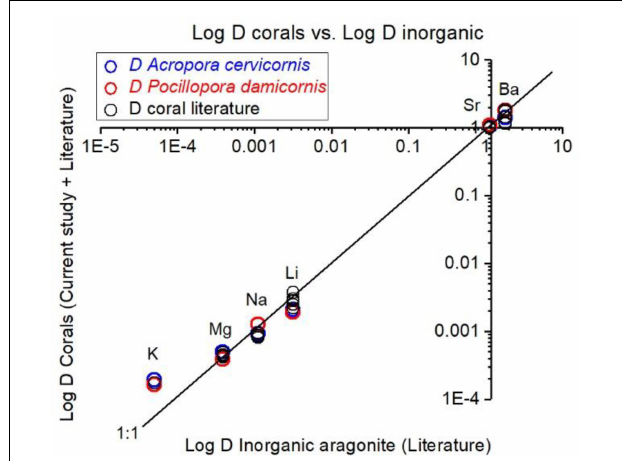
FIGURE 4 | Experimental D El values and literature values for corals, compared inorganic D El of aragonite. Our coral D El values agree well with literature coral values. For Ba, Sr, Mg, and Na the coral values are close to inorganic D values. For Li, inorganic D is higher than values in our experiments and for most of field collected corals (25 ◦ C). For K, inorganic D value is significantly lower than all corals. Suggested explanations for these discrepancies are explained in the section “Discussion.”